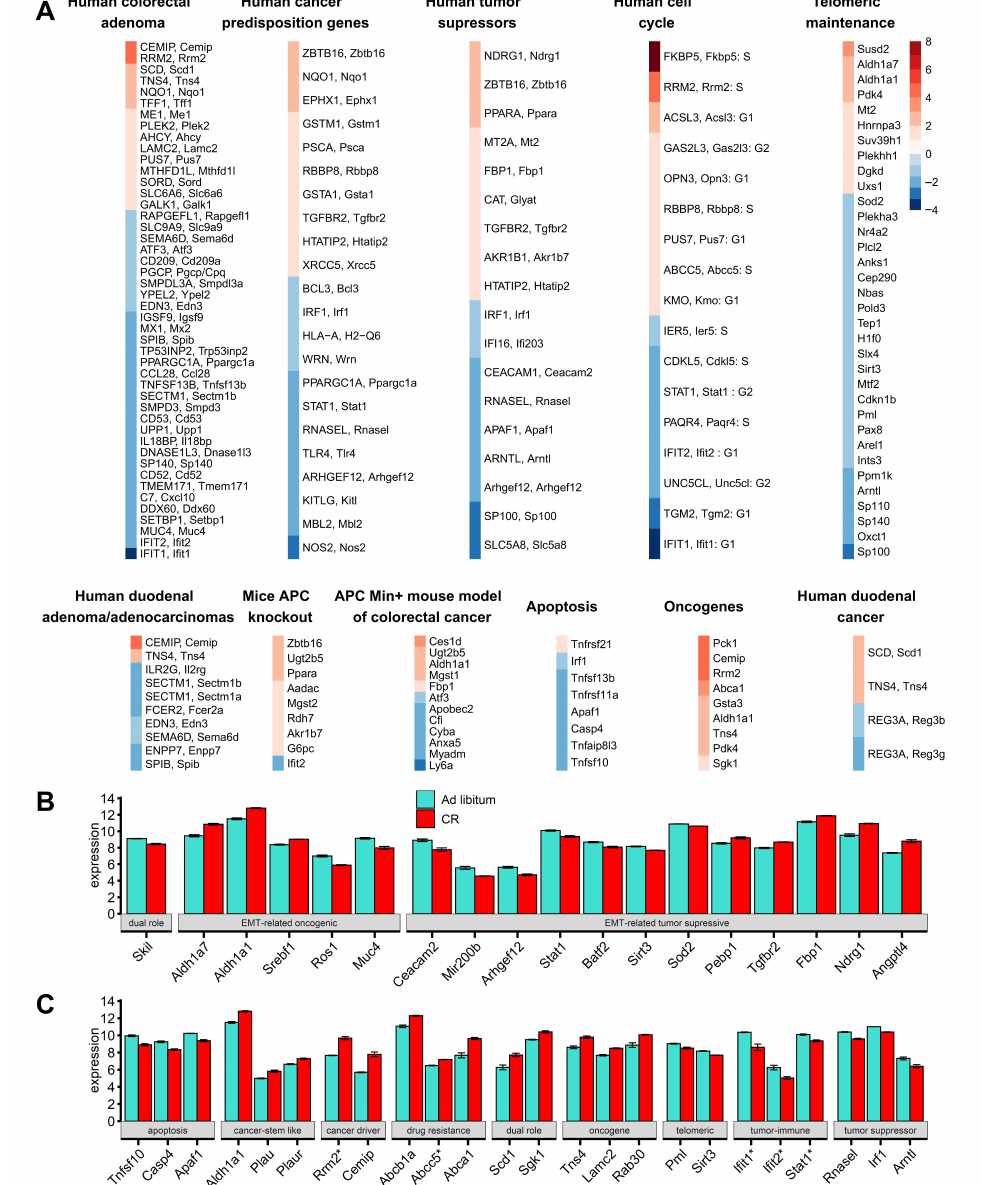
Figure 2. Categorization of CR-induced DEG subsets and their heatmaps. ( A ) When human/mouse gene orthologs are both present as labels, this indicates the original meta dataset used was human. The heatmap is colored by the gene expression fold change (FC) in CR DM mice (orange up, blue downregulated gene). Only matching directionality gene expression changes were included when comparing to the 505 CR mice DEGs (upregulated in both mice CR model and human colorectal adenoma, duodenal cancer, and duodenal adenoma/adenocarcinoma or both models downregulated). Data S3 lists the exact FC in previous models. Similarly, matched directionality gene expression changes for mice Apc knockout/APC Min/+ upregulated and CR mice downregulated or Apc knockout/APC Min/+ downregulated and CR upregulated was included. Human tumor suppressors were all suppressed in colon adenocarcinoma. Human cancer predisposition genes, telomeric maintenance, human cell cycle, apoptosis, and oncogene directionality in cancer models is not indicated. ( B ) Data are presented as the mean ± SEM (adjusted p -value < 0.05) for EMT-related CR DEGs with oncogenic, tumor-suppressive, or dual roles. ( C ) Selected CR DEGs presented as the mean ± SEM (adj. p -value < 0.05) representing key proliferative, oncogene, tumor suppressor, apoptotic, stem-like epithelial, tumor-immune surveillance, and telomeric genes which may play negative roles in the mucosa. Sgk1 and Scd1 (CR-upregulated) play dual roles in cancer progression, however, their upregulation promotes tumor growth and migration for colorectal carcinoma [43] and gastric cancer [44]. Genes with asterisks indicate cell cycle